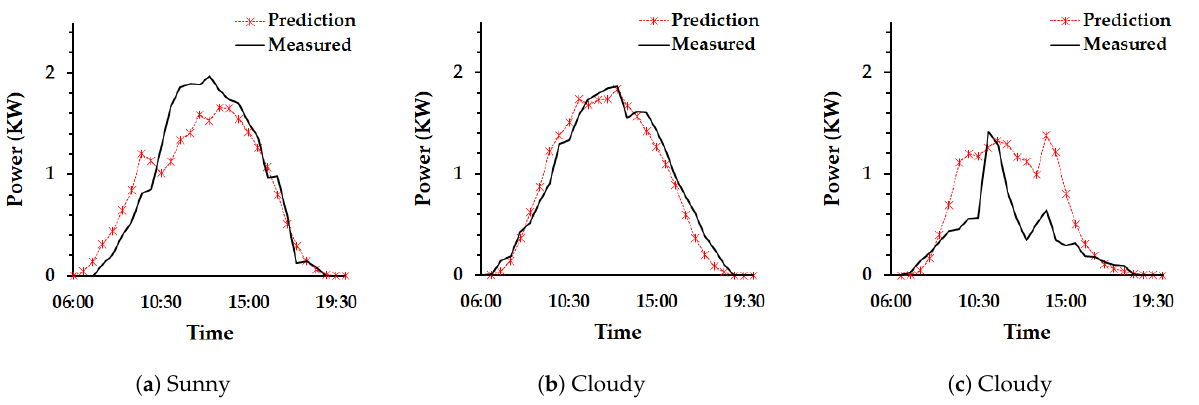
Figure 14. The 3 h ahead short-term forecast (SI = 30 m, PDL = 12 h, Layer =